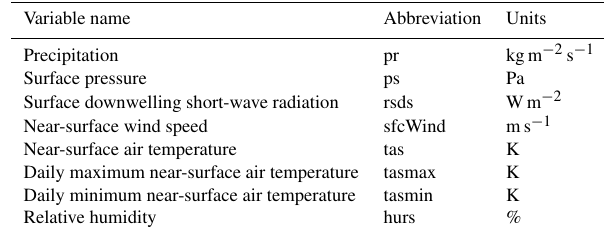
Table 1. Bias-corrected variables in the ISIMIP data